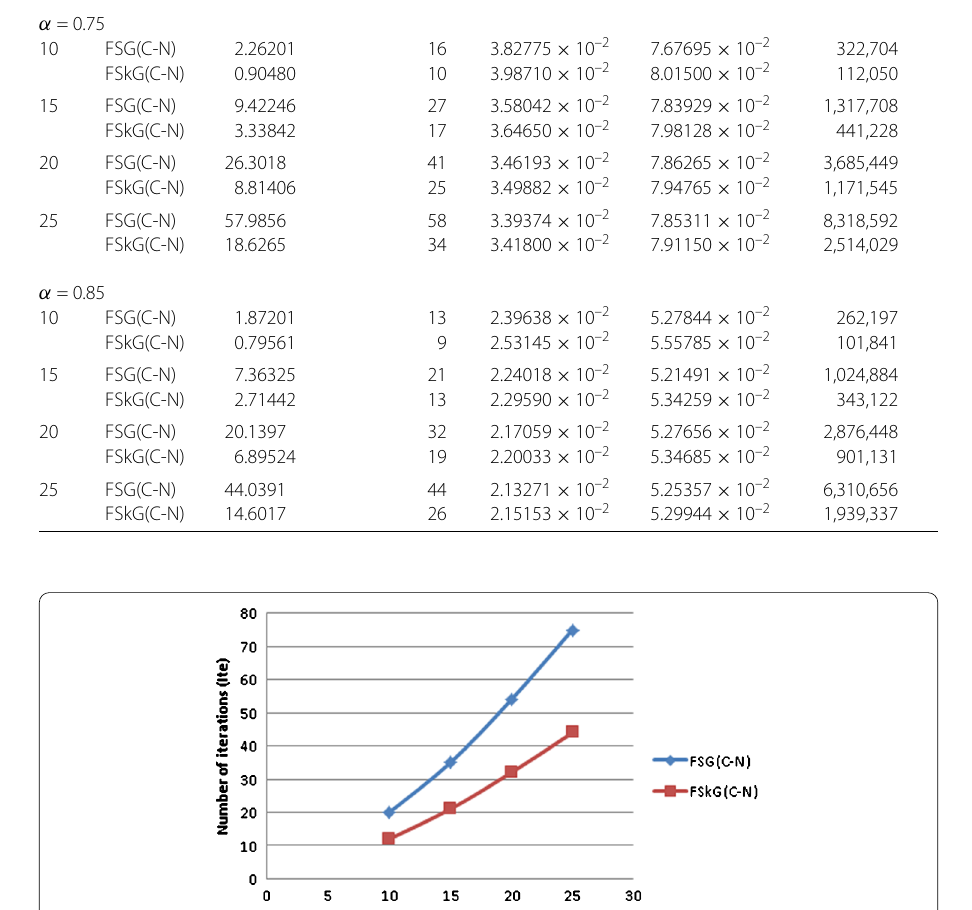
Figure 4 Graph of the number of iterations when α = 0.65 of Example 1